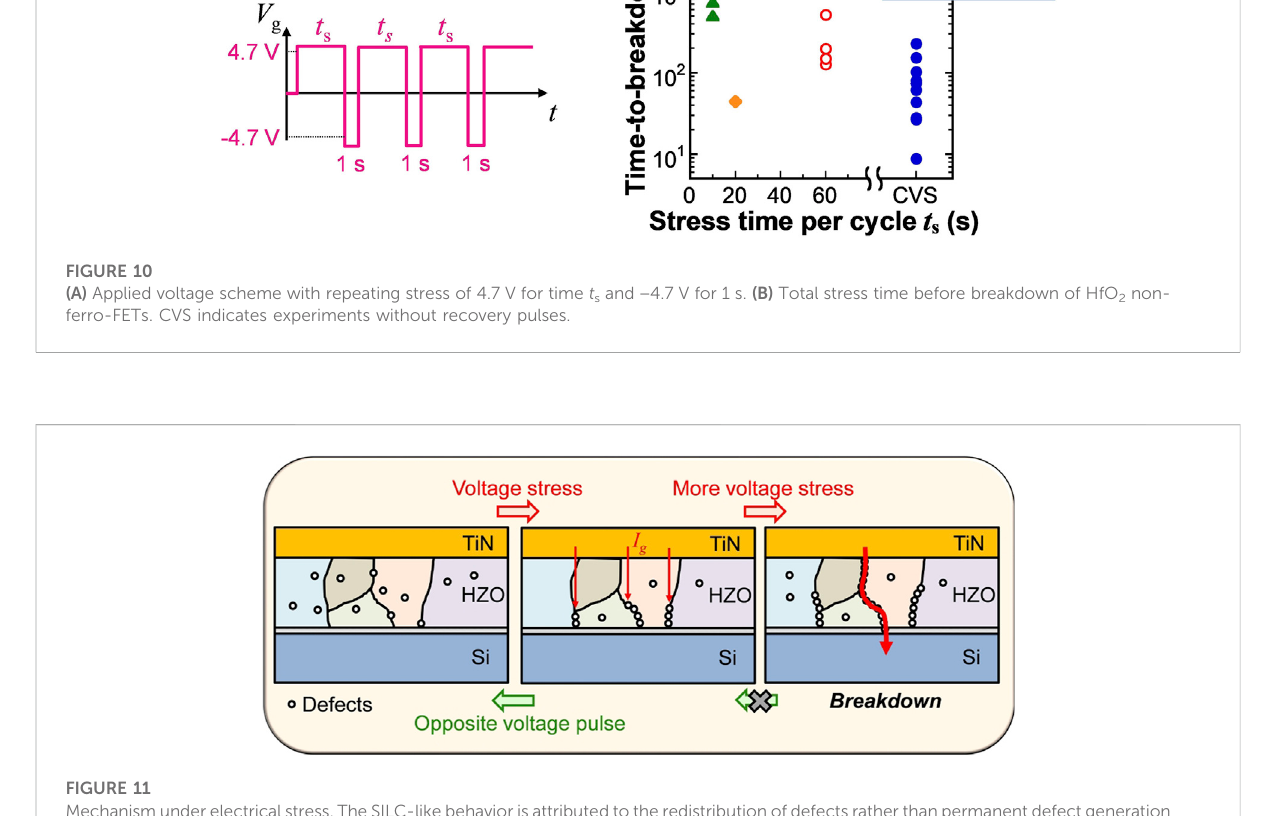
Mechanism underelectrical stress.The SILC-likebehaviorisattributedtotheredistribution ofdefectsrather than permanentdefect generation as recovery is observed. Too much stress will trigger